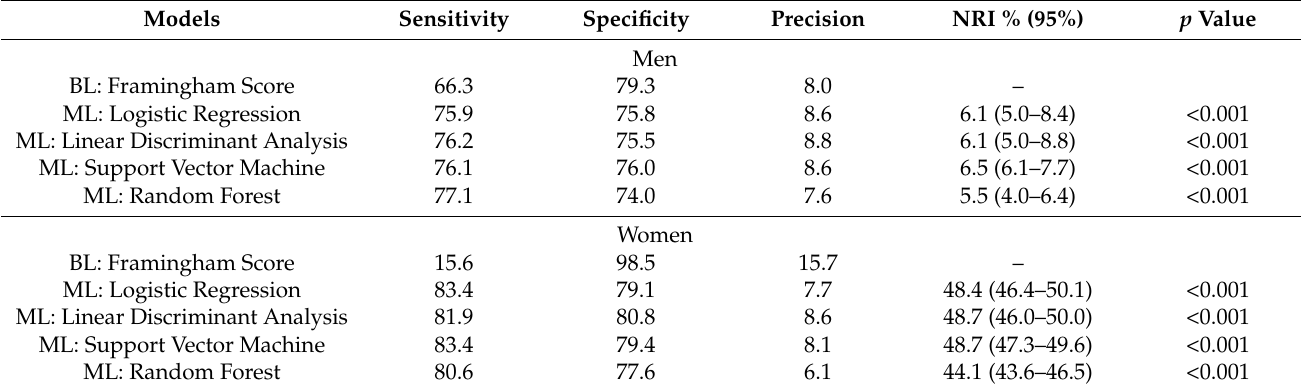
Table 7. Two-fold cross validation: Comparison of the classification (Sensitivity, Specificity, Precision) and NRI performance of Framingham Score (baseline model (BL)) and four machine learning (ML) models predicting 15-year risk of CVD mortality using combined data based on Sex stratification.